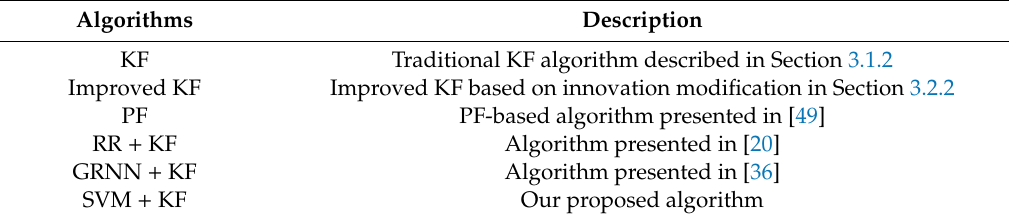
Table 2. Details relevant to the comparison of used